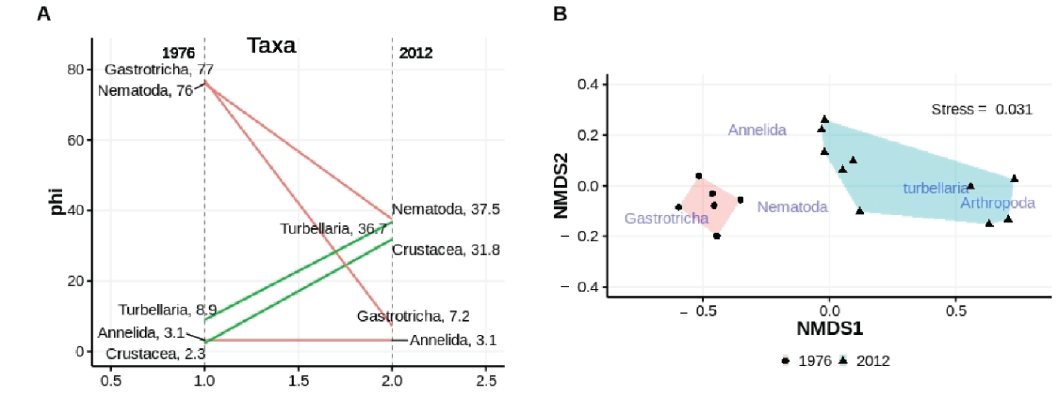
Figure 9. Univariate ( A ) and multivariate ( B ) comparisons of abundances of major taxa collected from the same tidal height at ISP in March 1976 and March 2012; non-metric scales serve to ease visual estimation of dissimilarity distances but are not associated with any specific units.